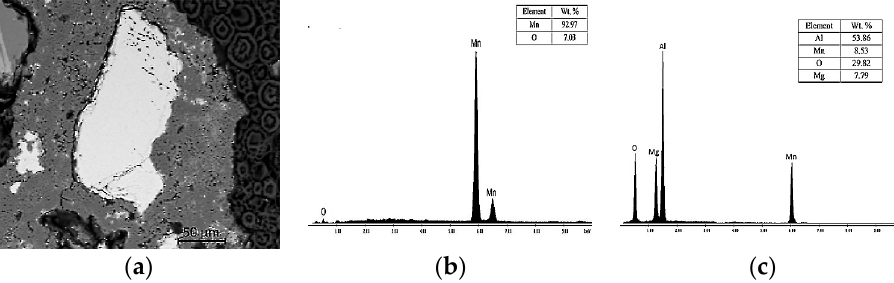
Figure 9. ( a ) SEM micrograph of a Mn rich particle, presumably the MgAl 2 O 4 , ( b ) pattern of Mn particle, and ( c ) pattern of spinel particles.